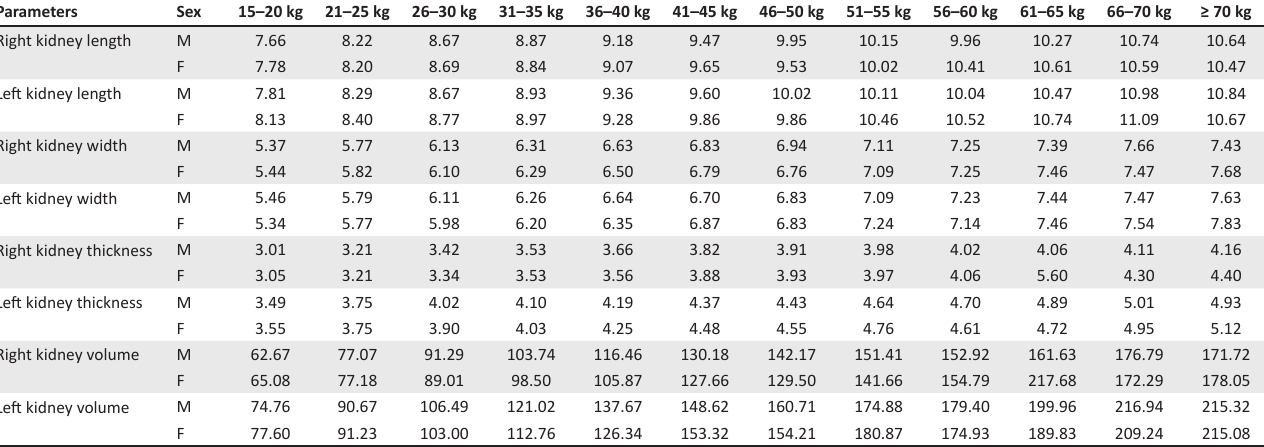
TABLE 3: Distribution of mean renal dimensions (cm) based on various weight categories (kg). Parameters Sex